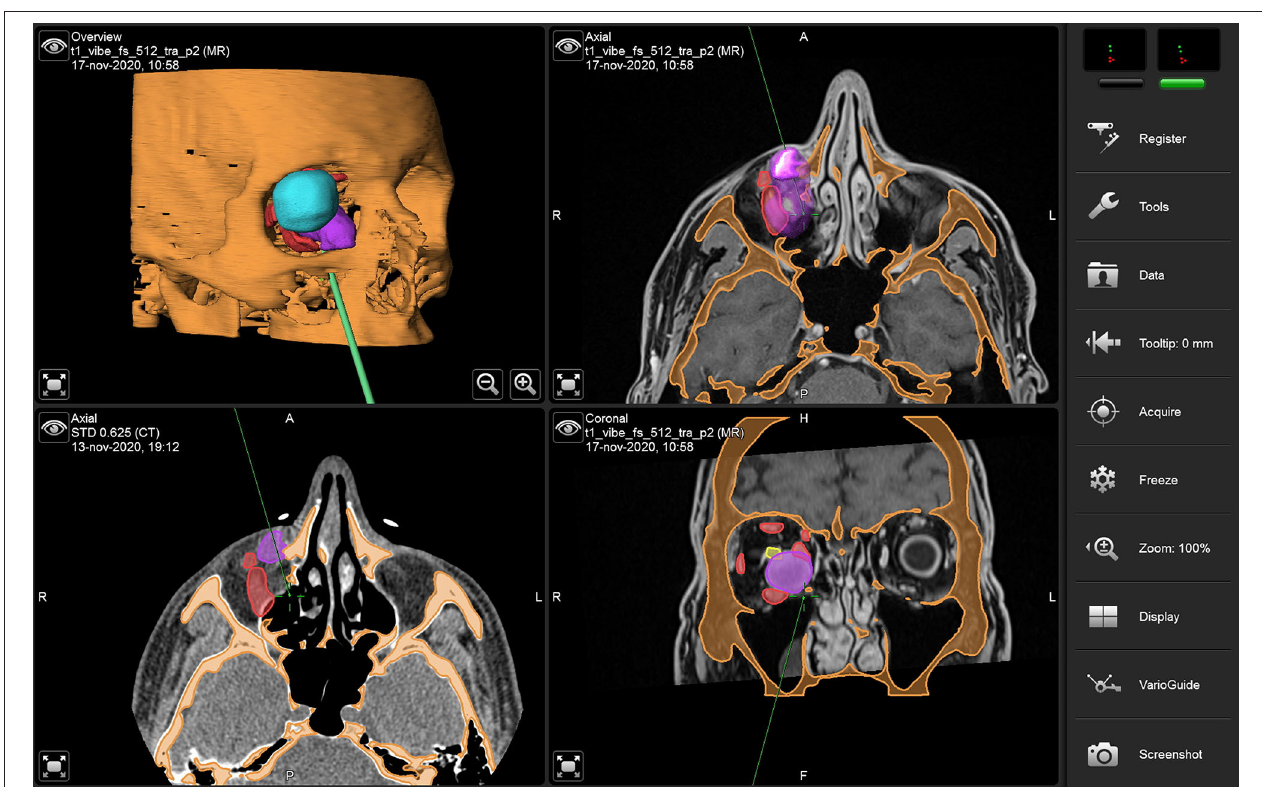
FIGURE 7 | Transmaxillary navigation during surgery using virtual models. The navigation probe indicates the medial edge of the orbital floor